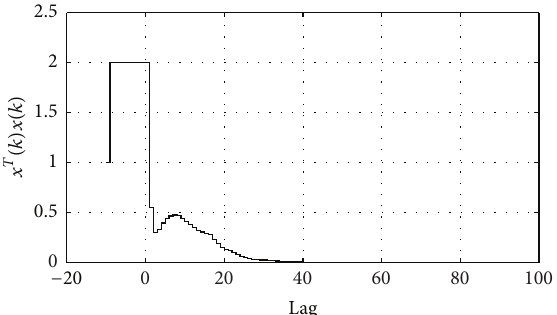
Figure 7: The norm of initial state response of system